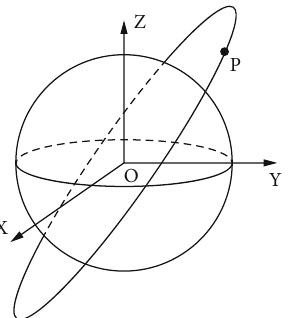
Figure 1: Diagram of the Earth-Centered Inertial (ECI) coordinate system.